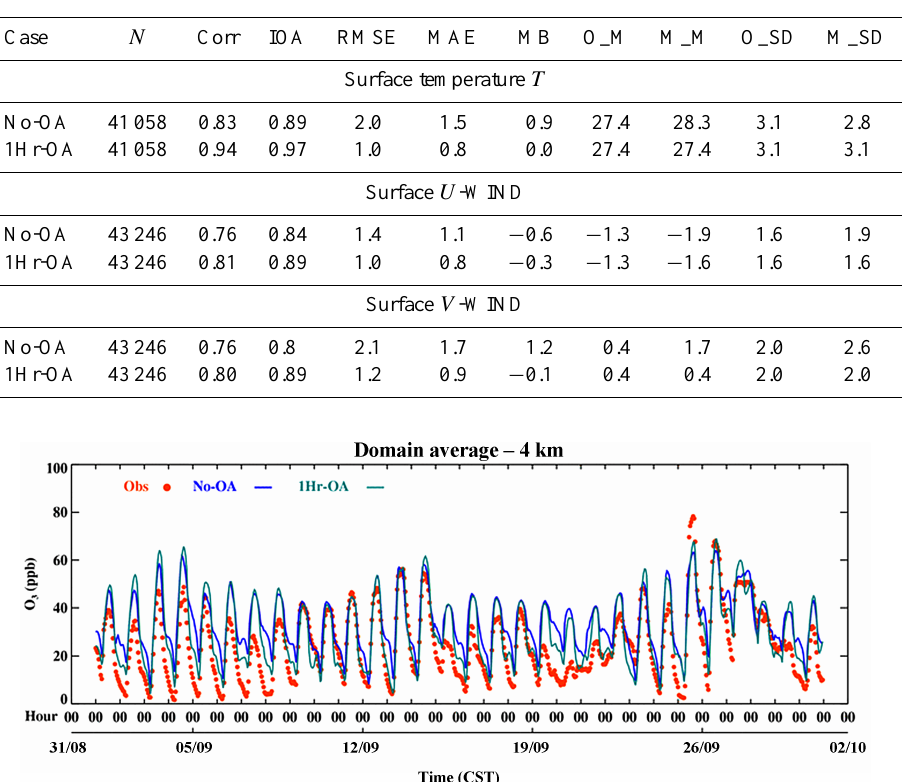
Table 3. Statistics of surface T , U-WIND, and V-WIND for three WRF simulations: N refers to data points, Corr to correlation, IOA to the index of agreement, RMSE to the root mean square error, MAE to the mean absolute error, MB to the mean bias, O to observation, M to model, O_M to observed mean, M_M to model mean, and SD to standard deviation. Units for RMSE/MAE/MB/O_M/M_M/O_SD/M_SD: temperature, ◦ C; winds ( U and V ), ms − 1 .